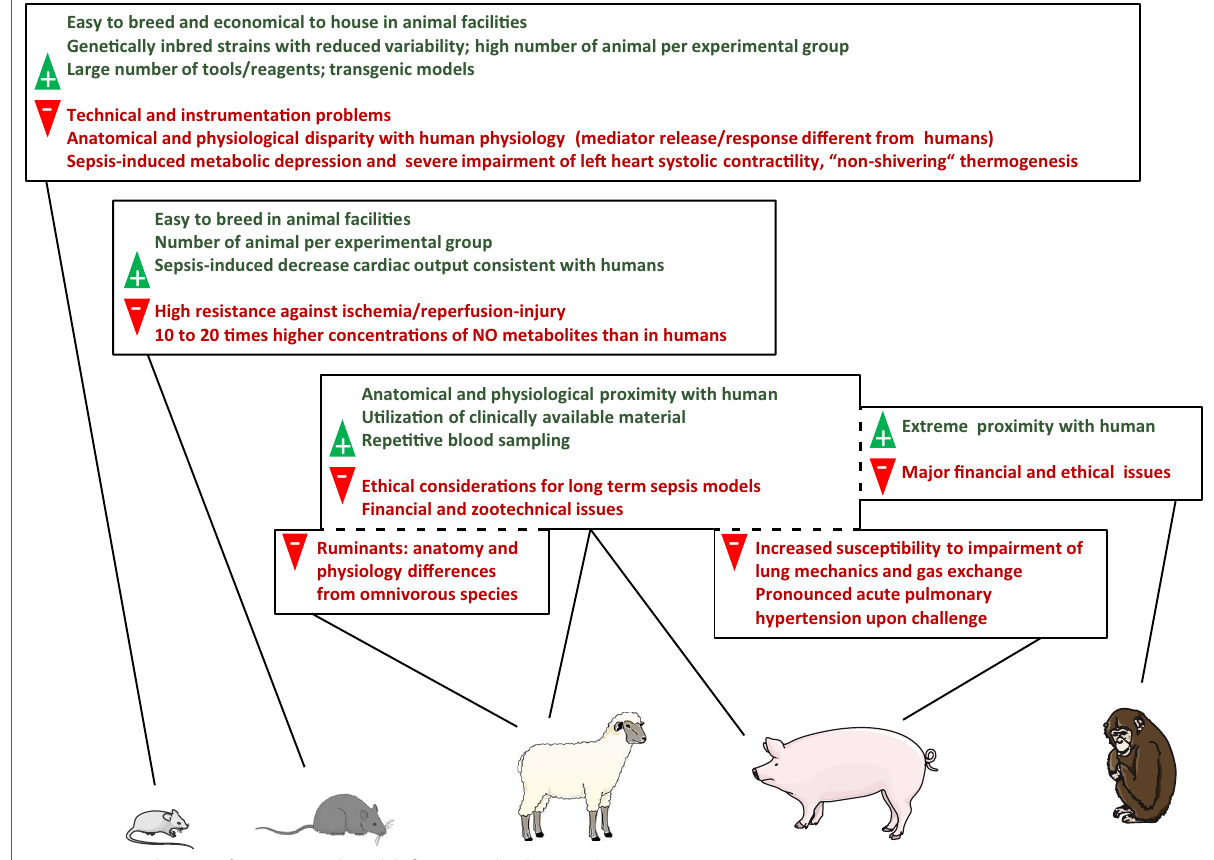
Fig. 1 “Pros” and “Cons” of experimental models for septic shock